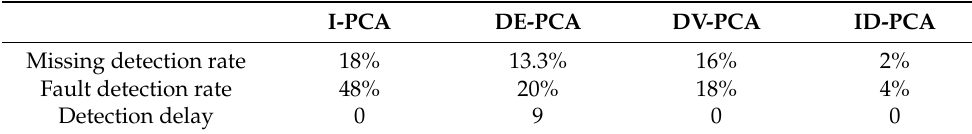
Table 3. The performance comparison for rolling bearing rolling body.